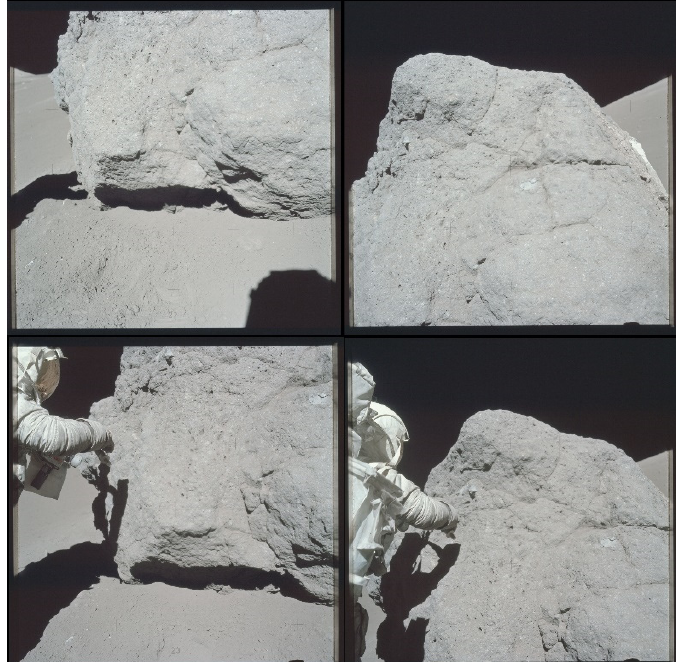
Figure 3. Example of the images of H. H. Schmitt taking rock samples during the third extravehicular activity at Station 7 (images labeled AS17 ‐ 146 ‐ 22335 to AS17 ‐ 146 ‐ 22338). There is sufficient overlap between these kind of sample images to allow a photogrammetric 3 ‐ D reconstruction of the boulder.